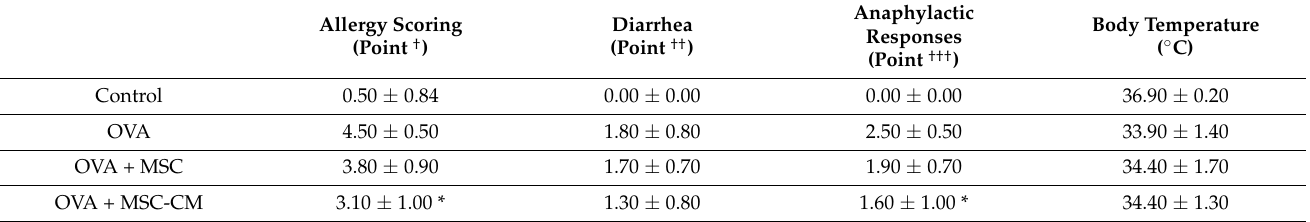
Table 1. Comparison of allergy scoring, diarrhea, anaphylactic responses, and body temperature. Allergy Scoring (Point † )